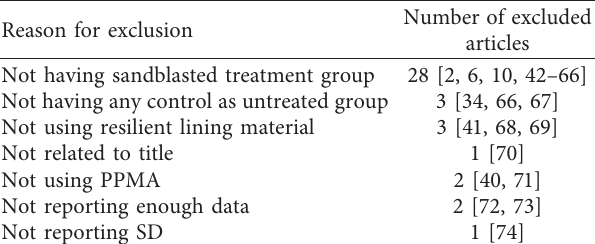
Figure 1: Flow diagram of screening the title, abstract, and full text. Table 2: Excluded studies at the full text level with reasons. Reason for